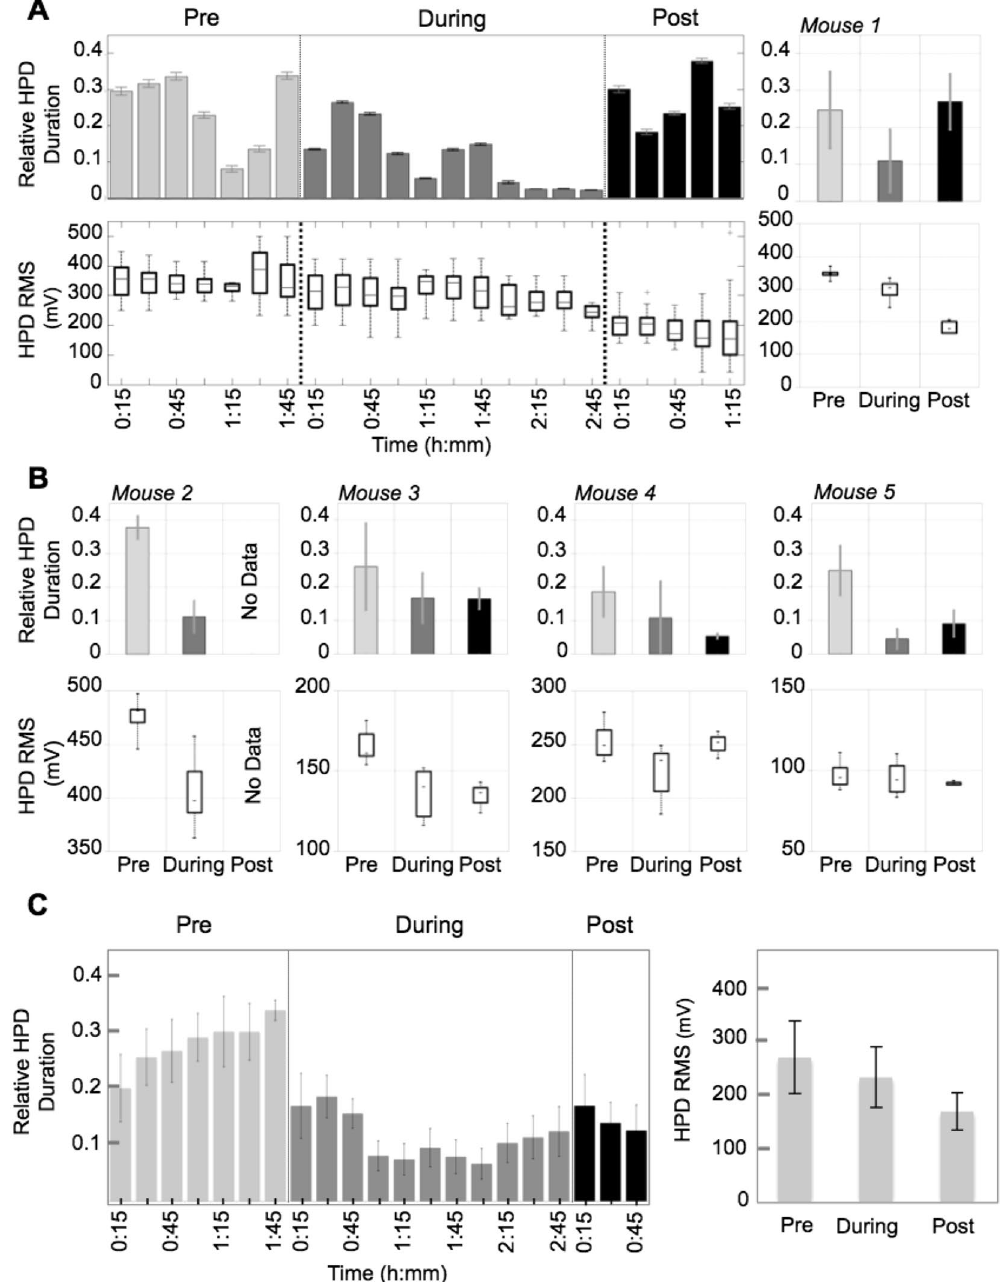
Figure 3. Effect of the cathodal stimulation on HPD occurrence and duration. ( A ) Upper left . Moving average of relative HPD duration over time, pre-, per- and post-stimulation. Lower left . Evolution of HPD RMS value over time, pre-, per- and post-stimulation. Upper right . Average relative HPD duration pre-, per- and post- stimulation for Mouse 1. Lower right . Average relative HPD duration pre-, per- and post-stimulation for Mouse 1. ( B ) Upper row . Average relative HPD duration pre-, per- and post-stimulation for Mouse 2, 3, 4 and 5. Lower row . Average relative HPD duration pre-, per- and post-stimulation for Mouse 2, 3, 4 and 5. ( C ) Group data : evolution, as a function of time, of the relative HPD duration averaged over the 5 animals (mouse 1–5). The relative HPD duration was defined as the HPD cumulated durations divided by the analysis window duration (chosen to be equal to 30